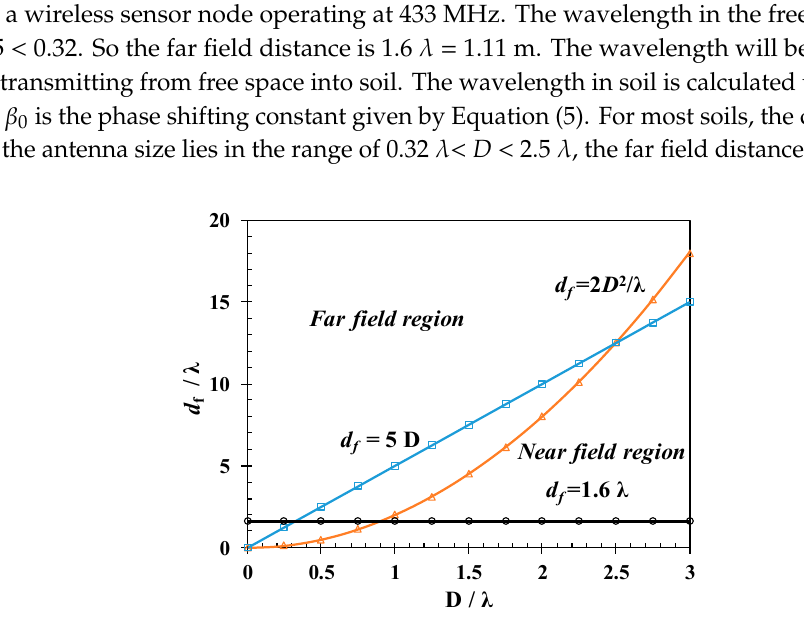
Figure 2. The three criteria of the far region as a function of normalized electrical antenna size ( D / λ ) .